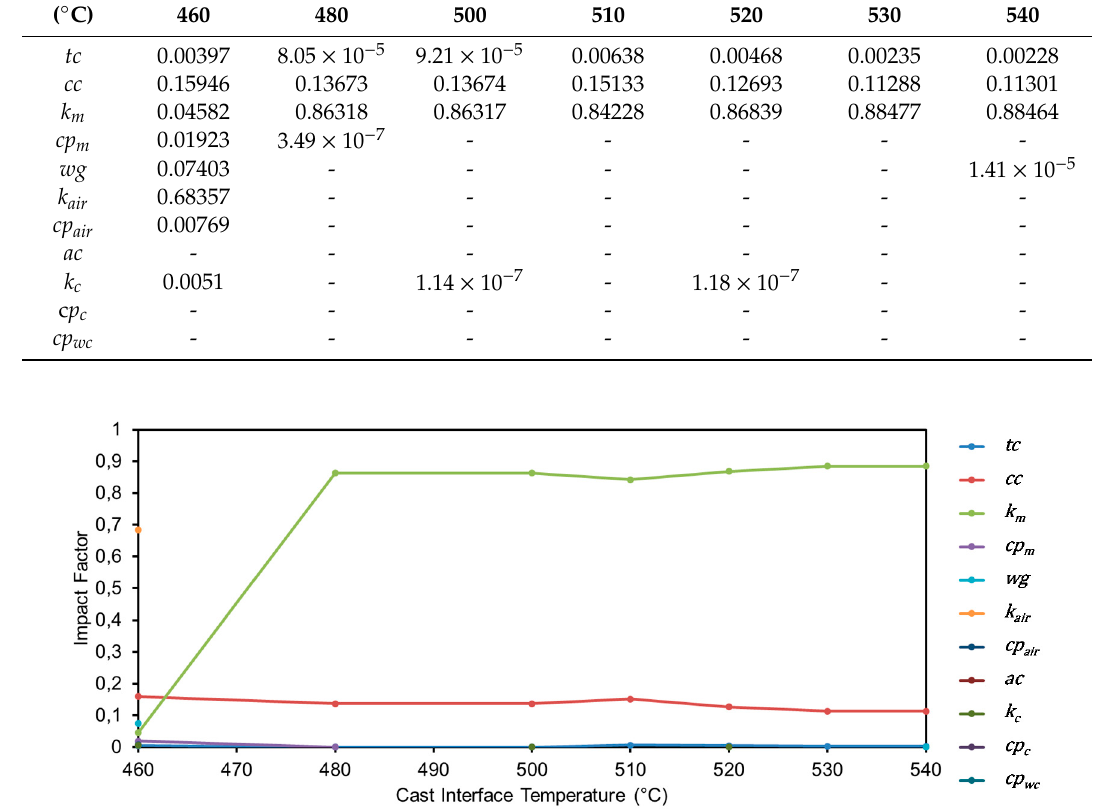
Figure 4. Development of the impact factors for the HTC between casting and mold over the interface temperatures.